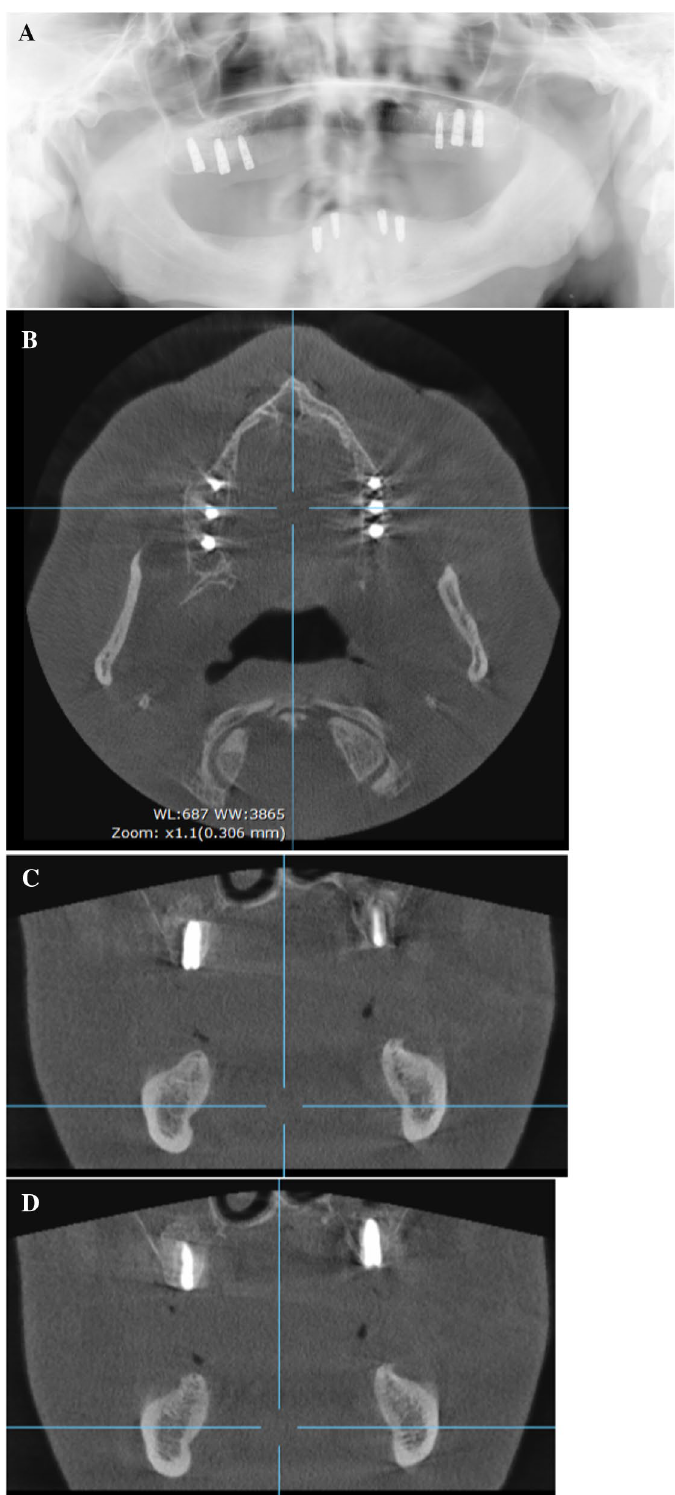
Fig. 3 Radiographic evaluation after one‑stage lateral sinus lift with simultaneous implantation. A Panoramic radiograph directly after alveolar ridge augmentation and simultaneous insertion of six dental implants. B Palatinal section of the CBCT illustrating the region of interest. C Sagittal section of the CBCT illustrating the region of interest in the first quadrant. D Sagittal section of the CBCT illustrating the region of interest in the second